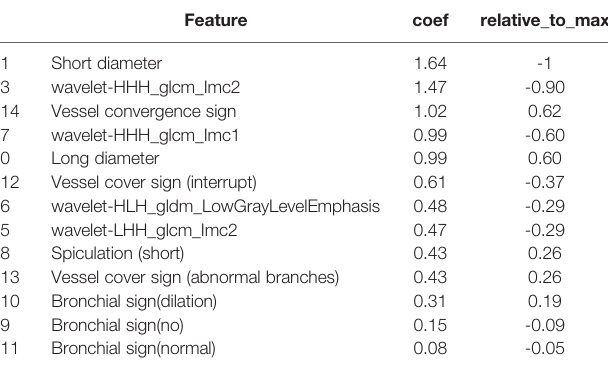
FIGURE 5 | The boxplots of morphological model (A) , radiomics model (B) , and combined model (C) . TABLE 3 | The selected features in combined model and weight index.